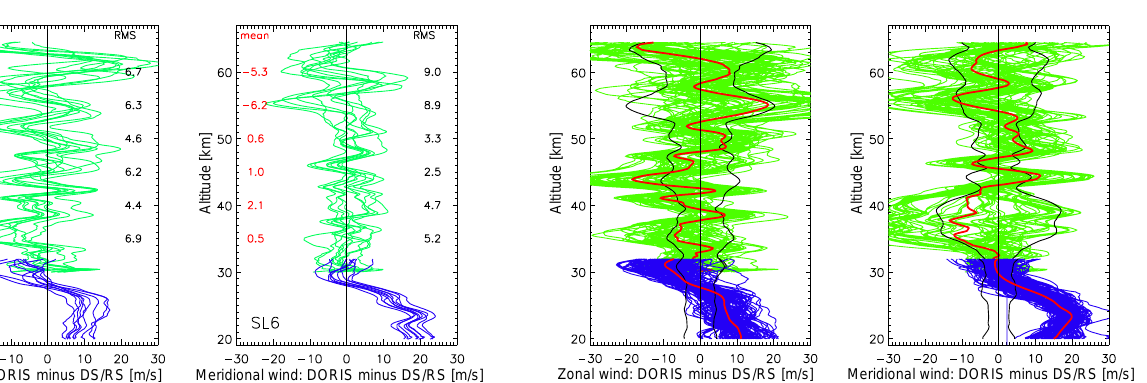
Figure 11. Differences between the DoRIS profiles shown in Fig. 9 and (i) the datasonde profile (green lines), and (ii) the radiosonde profile (blue lines). See text for more details. Left: zonal winds, right: meridional winds.